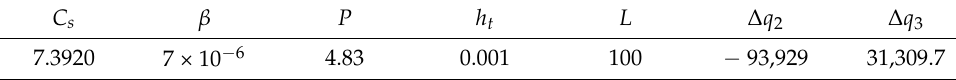
Table 2. Nominal parameters value.